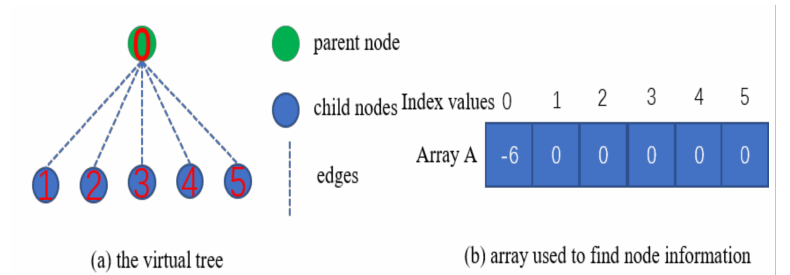
Figure 4. Union-find sets: ( a ) the virtual tree; ( b ) the array used to find node information.